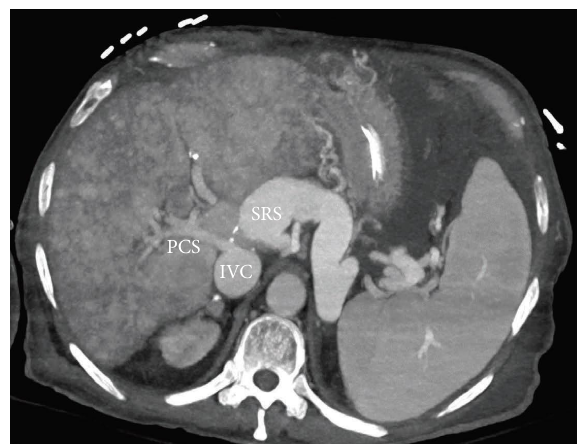
Figure 1: Maximum intensity projection contrast enhanced computed tomography showing the anatomical relationship be- tween the transplant portocaval shunt (PCS), inferior vena cava (IVC), and the massive splenorenal shunt (SRS).